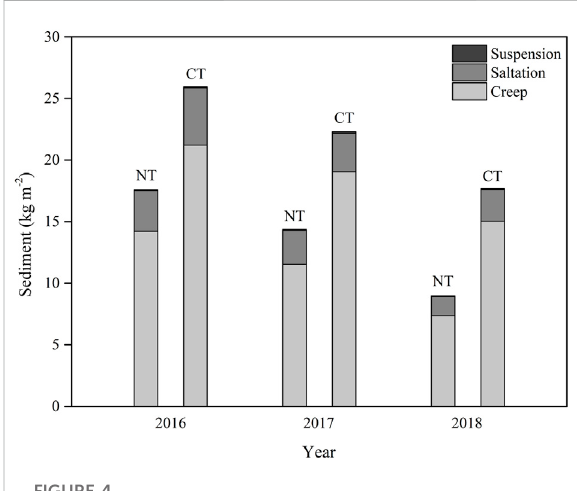
FIGURE 4 Total erodible particles (creep, saltation, and suspension) during 1st April to 1st June under different tillage treatments in Northeast China by the rBSNE sampler (2016 – 2018).